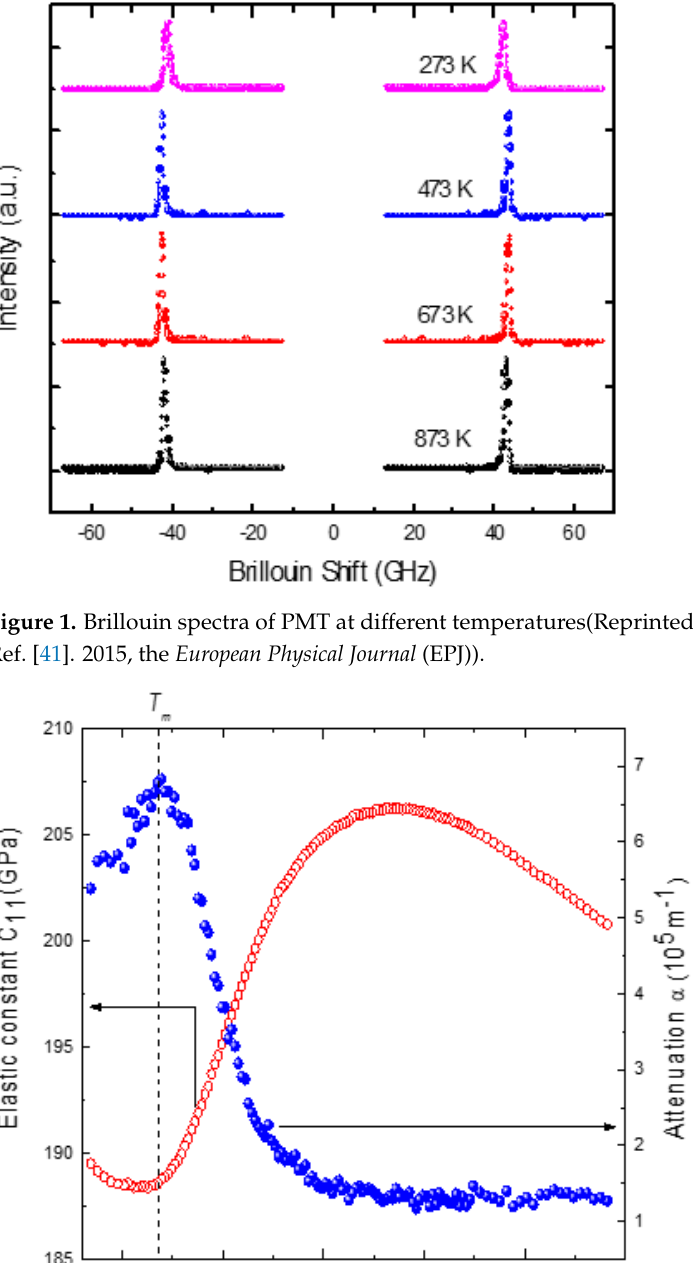
(open circles) and attenuation α 11